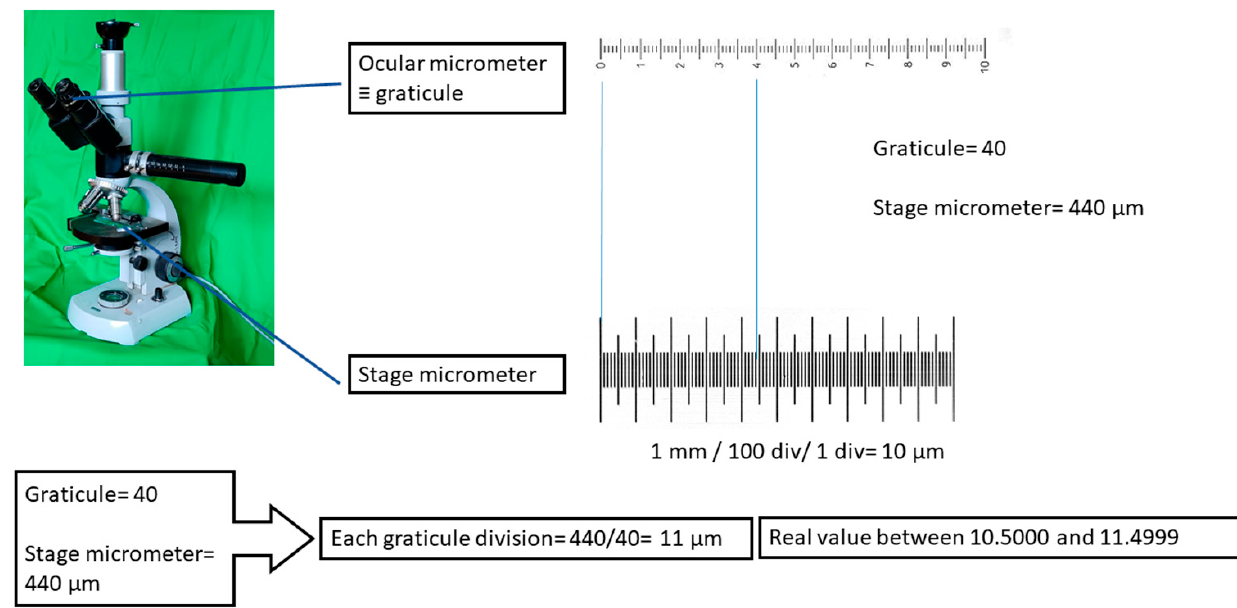
optical Figure 2. Example of how the calibrating factor to be used in measurements is obtained on an optical microscope.